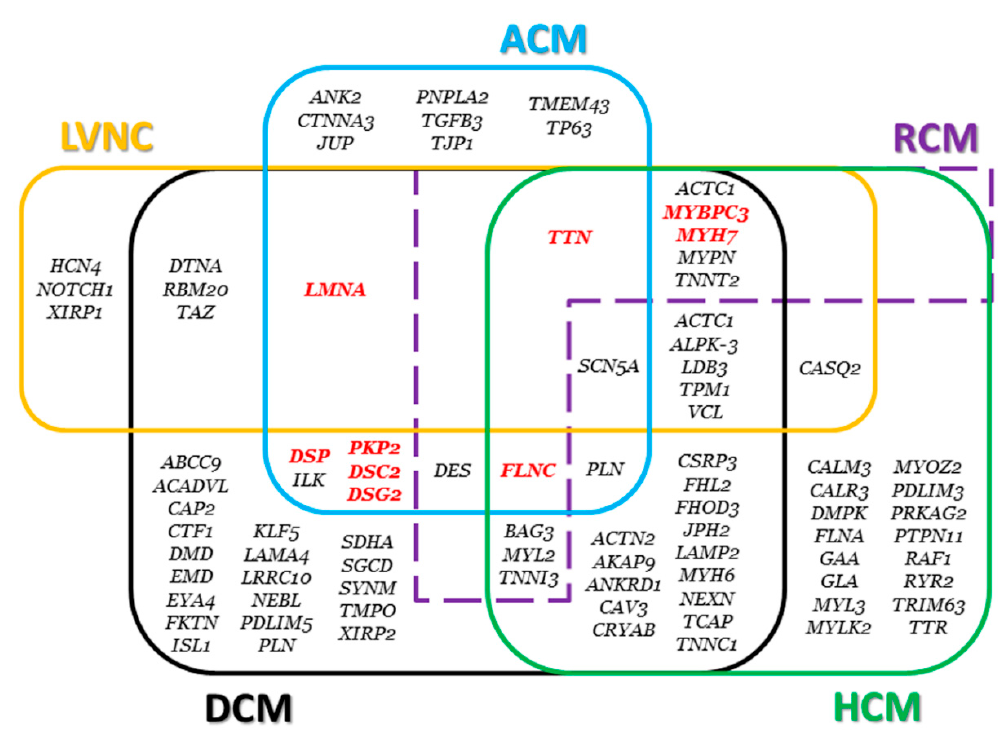
Figure 7. Genes associated with cardiomyopathies. The main genes are highlighted in red. Genes associated with restrictive cardiomyopathy (RCM) and left ventricular noncompaction (LVNC) are also displayed.